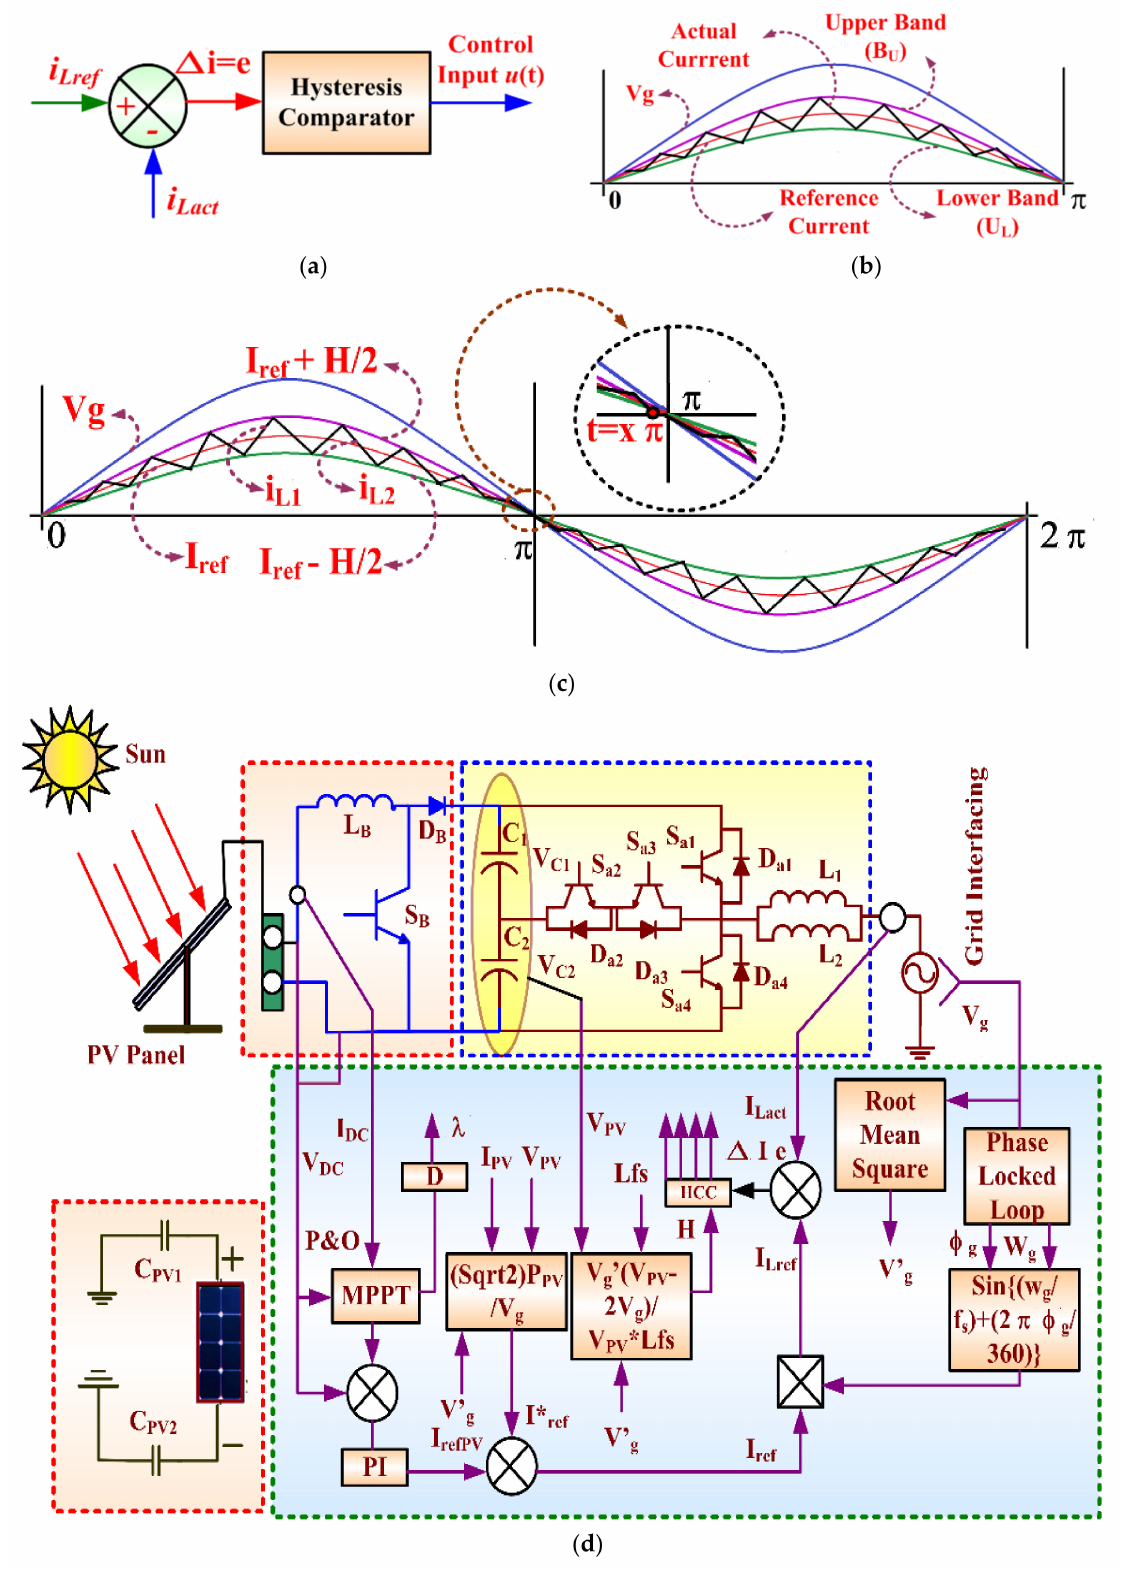
Figure 3. Control Logic ( a ) Basic block diagram. ( b ) Hysteresis switching assortment. ( c ) HCC band and inductor current control with grid voltage. ( d ) Closed-loop PV connected single-phase three-level transformer-less TNP-MLI PV-grid- connected system control